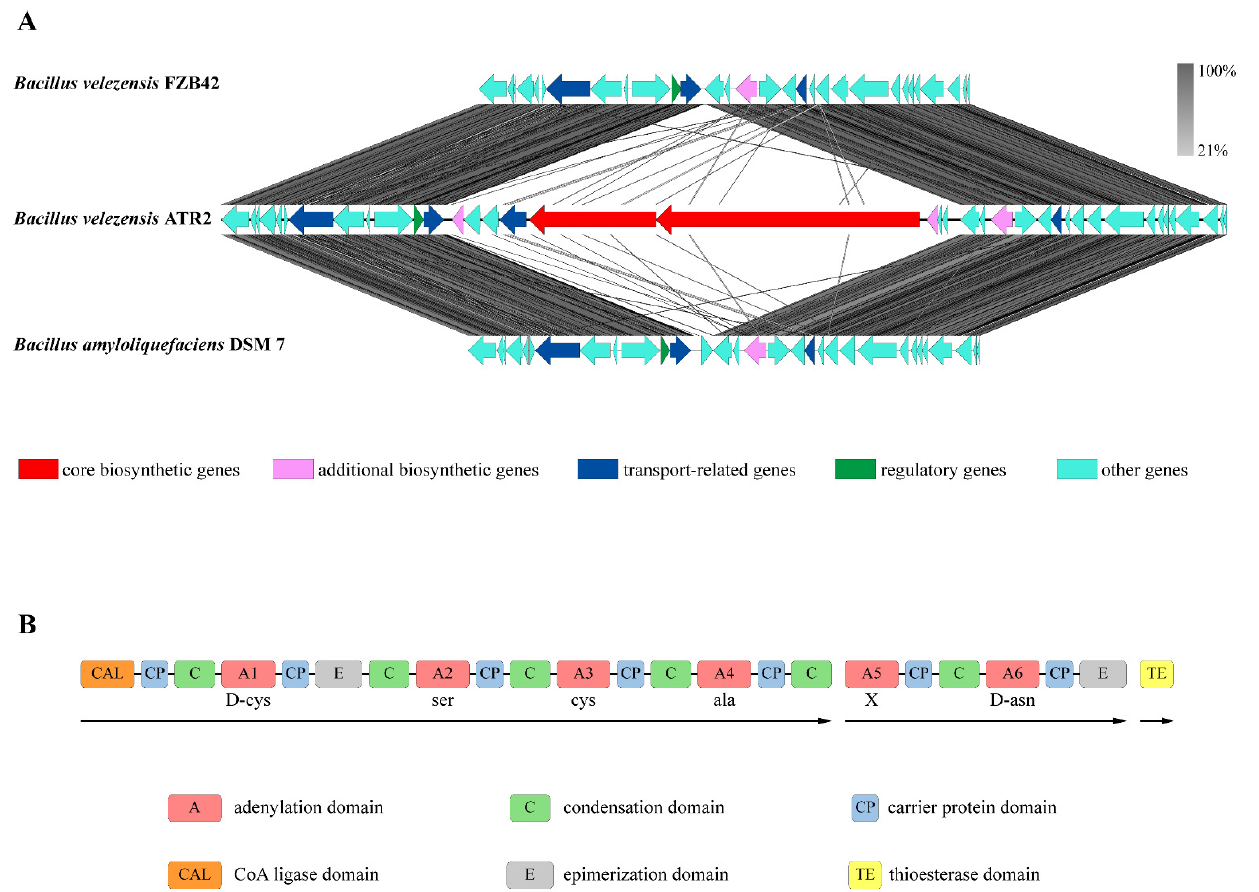
Figure 2. Gene cluster for the putative lipopeptide. ( A ), The putative lipopeptide gene cluster and surrounding genes on the B. velezensis ATR2 chromosome. The same locus of B. velezensis FZB42 and B. amyloquefaciens DSM 7 T were also presented for comparison. Gray bars indicated the similarity which was calculated via tblastx with the Easyfig tool [58]. ( B ), Schematic representation of the putative lipopeptide gene cluster. Three NRPS subunits were indicated with arrows. The predicted amino acids were also shown (X for unidentified amino acid). In addition, functional protein domains were indicated as A for adenylation domain; C, condensation domain; CP, carrier protein domain; E, epimerization domain; CAL, CoA ligase domain; and TE, thioesterase domain.